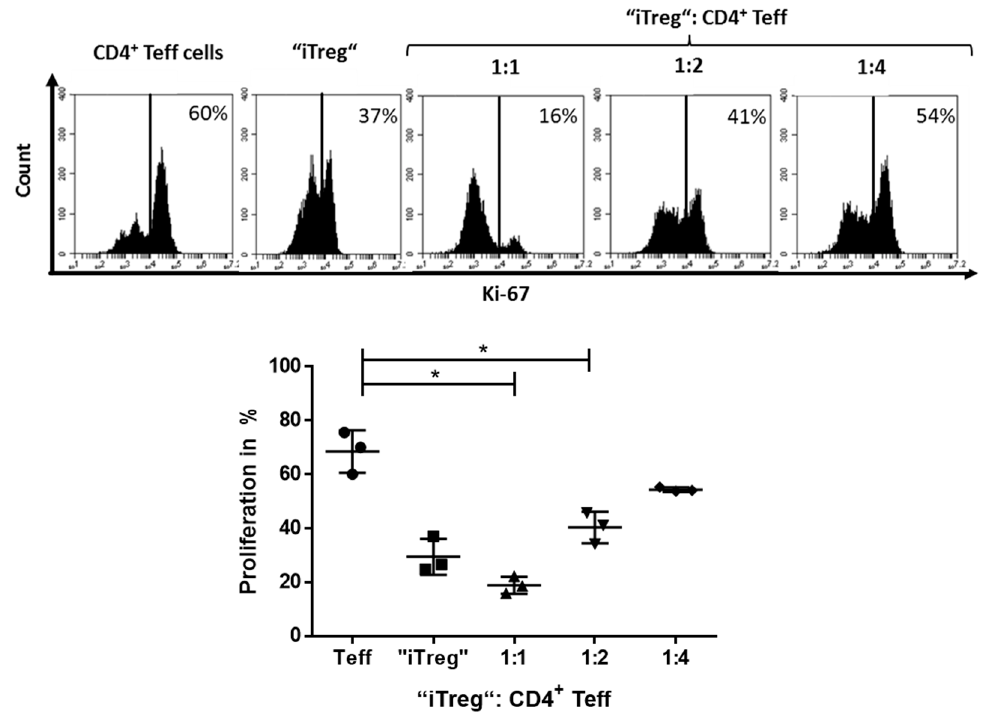
Figure 3. Platelet-induced iTreg suppressed T effector cells (Teff) cells. To analyze iTreg induction by platelets, we expanded CD4 + CD25 − T cells for 6 days in the presence of platelets at the ratio of 1:50, as described previously, and were subsequently incubated at various ratios with 0.5 × 10 5 CD4 + CD25 − T cells and restimulated with 1 × 10 5 irradiated peripheral blood mononuclear cells (PBMC) and 0.5 µg/mL anti-CD3 mAb. Proliferation was determined on day 3 of culture by Ki-67 staining ( n = 3, means ± SD, * p < 0.05, ** p ≤ 0.01, *** p ≤ 0.001, and n.s. determined by one-way ANOVA).